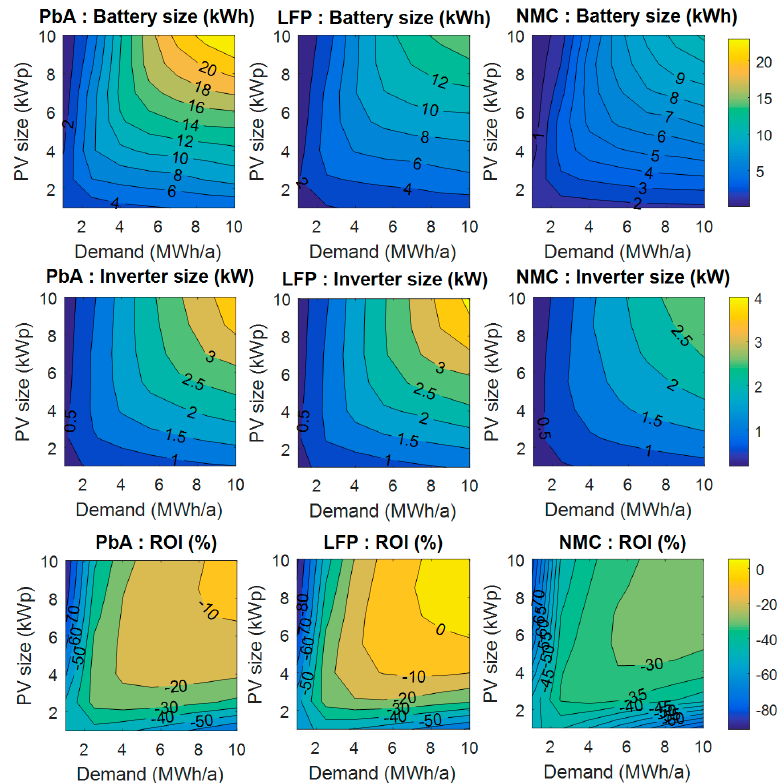
Figure 3. Graphical representation of the optimization results using contour plots: from top to bottom, the panels show optimum battery size, inverter size, and corresponding maximum attainable return on investment (ROI) for a variation of yearly load demand and local PV generation. From left to right, three battery technologies (lead-acid (PbA), LFP, and lithium-nickel-manganese-cobalt (NMC)) are